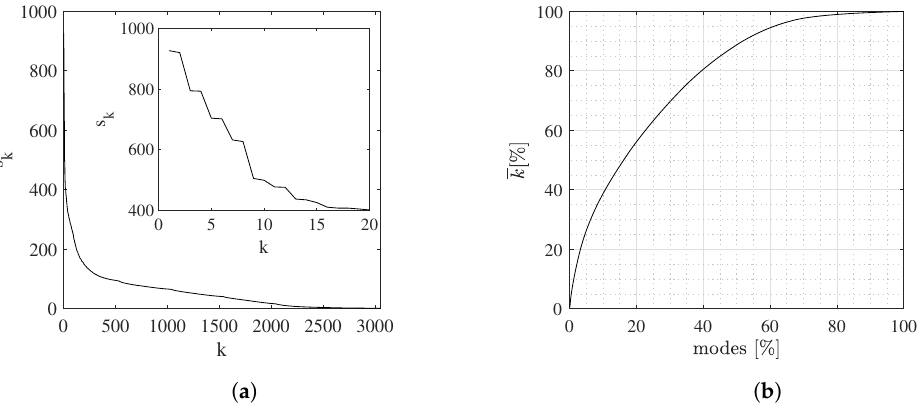
Figure 3. ( a ) Singular values distribution with a close up for the first 20 modes. ( b ) Cumulative turbulent kinetic energy distribution versus the fraction of POD